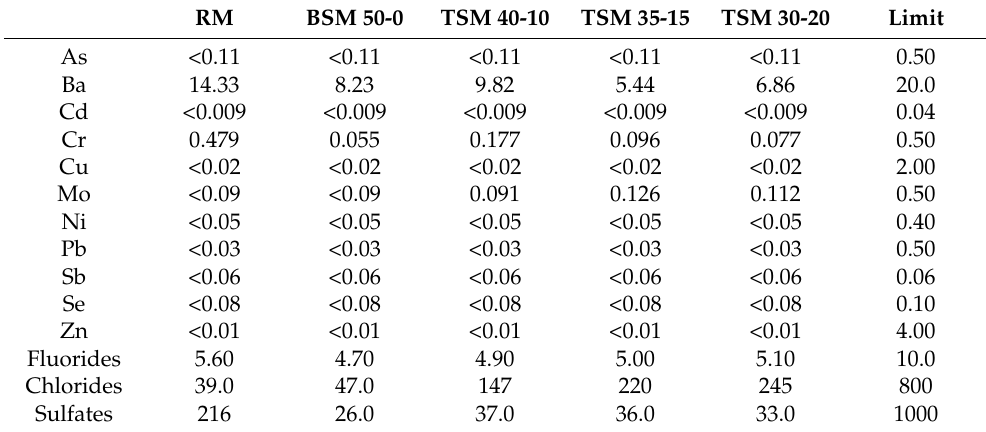
Table 10. Mobility of heavy metals in the studied formulations (mg/kg).